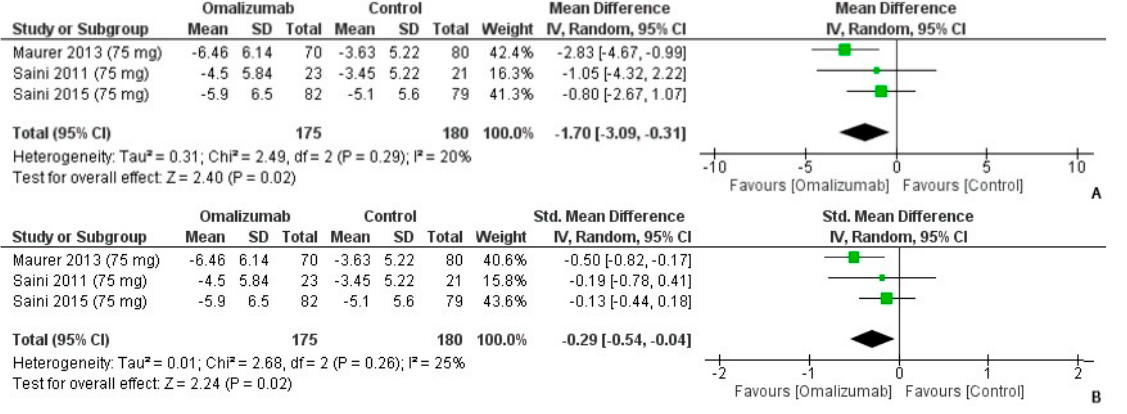
Figure 2. Weekly Itch Score Outcomes with 75 mg dosage of omalizumab [18,19,23]. ( A ): Mean